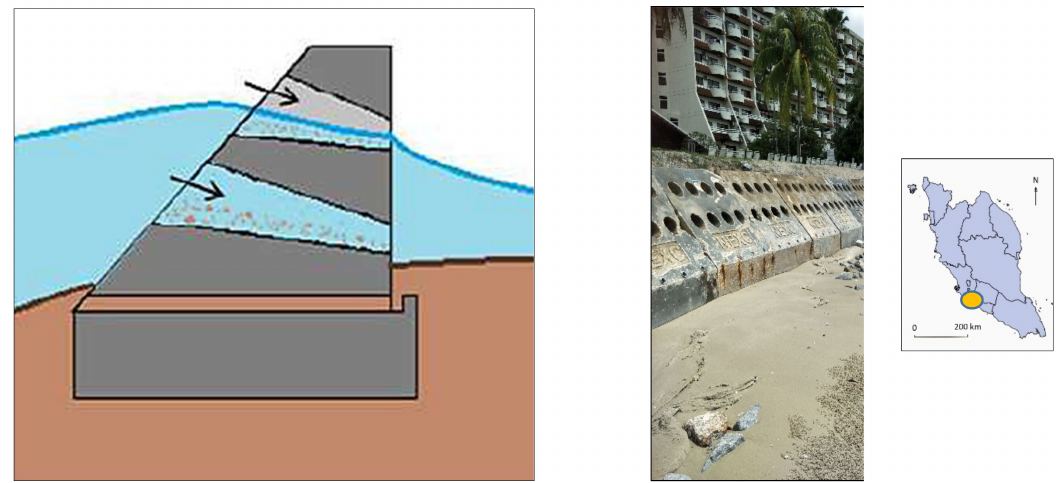
Figure 4. Innovative porous concrete seawall developed in Port Dickson by